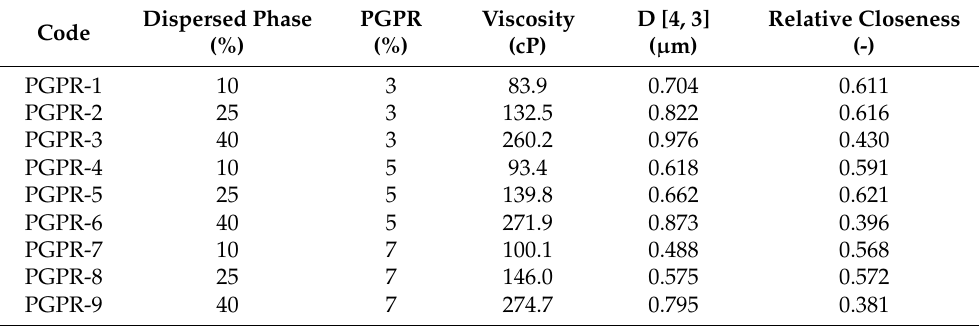
Table 3. Technique for order of preference by similarity to ideal solution (TOPSIS) similarity values for the emulsions prepared by PGPR